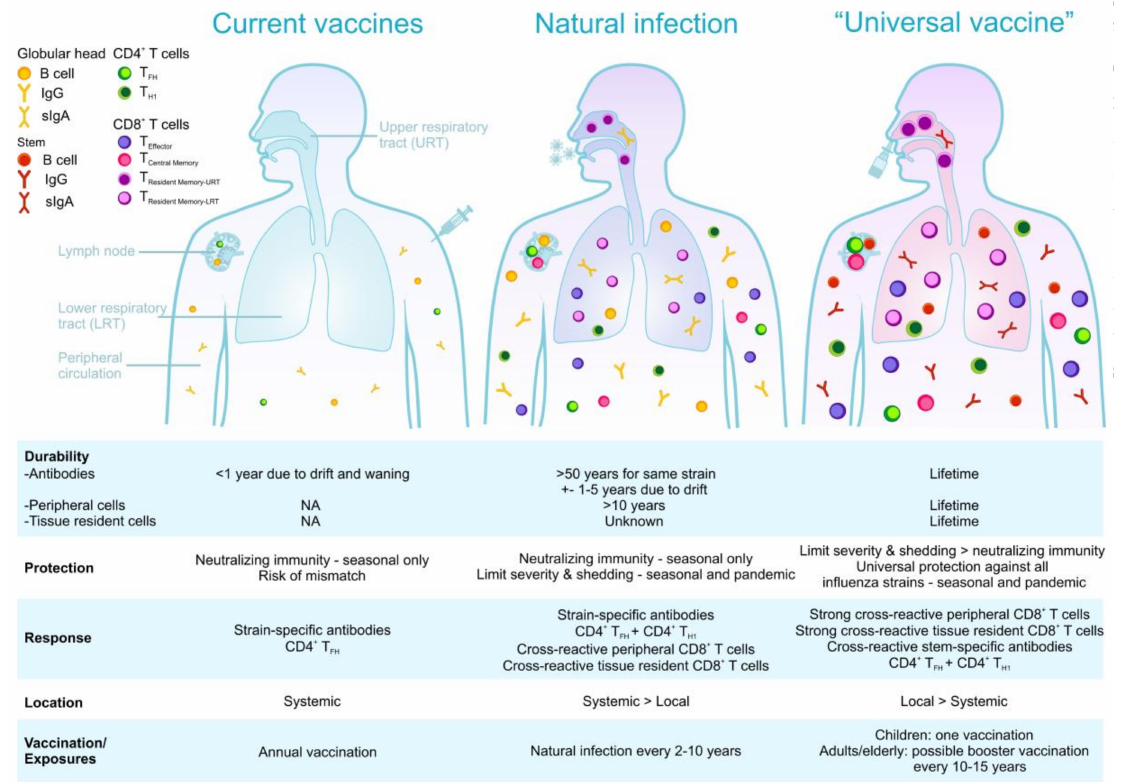
Figure 2. Immune responses stimulated by natural influenza virus infection, current vaccination, and the ideal scenario of a universal